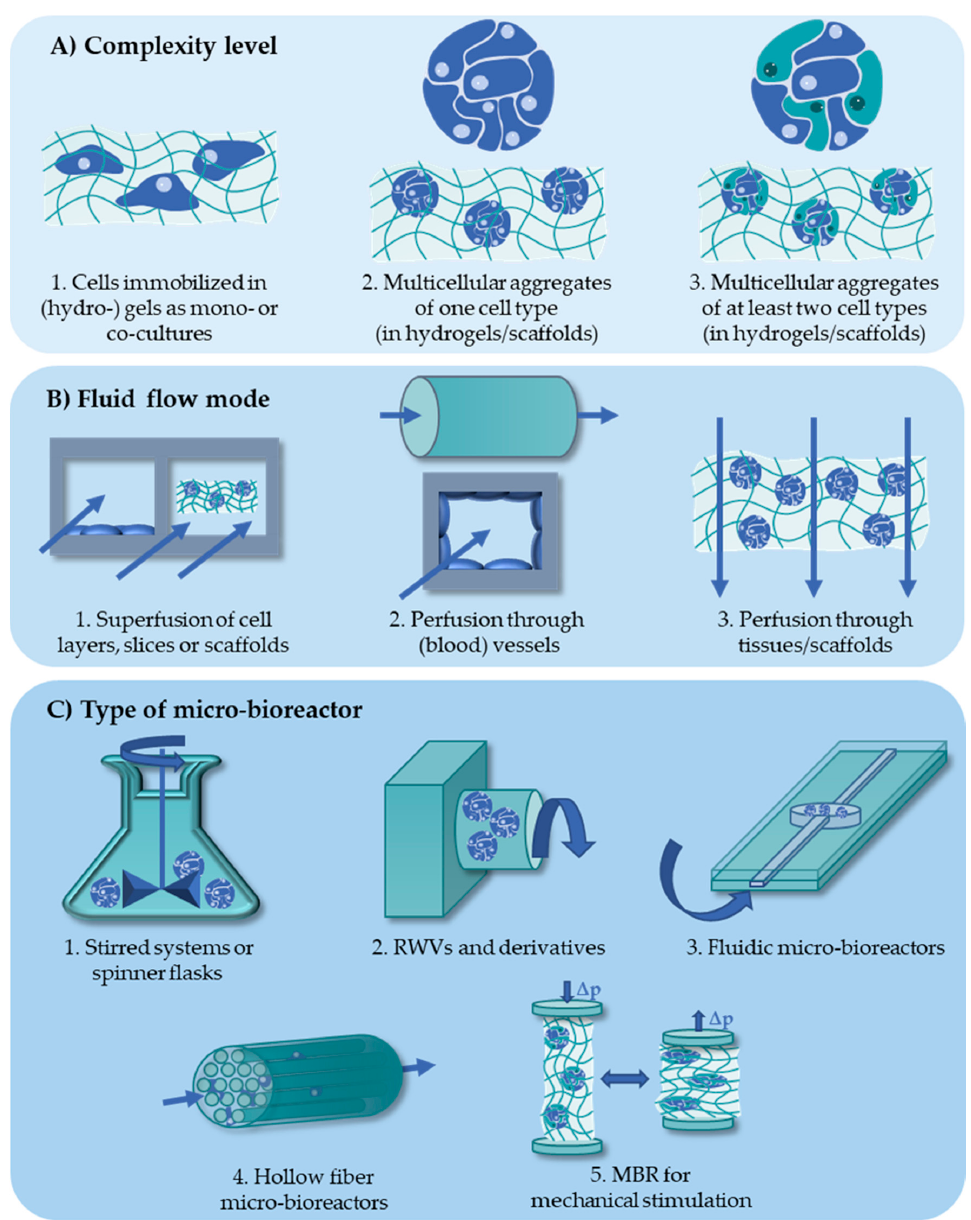
Figure 2. ( A ) Complexity levels defined by means of the applied 3D cell culture technique and with respect to the existing 3D microenvironment. ( B ) Differentiation between superfusion and perfusion of different 3D cell cultures. ( C ) Frequently used micro ‐ bioreactor (MBR) types: 1. based on spinner flasks or stirred tank systems, 2. rotating wall vessels (RWVs), 3. fluidic MBR, 4. hollow fiber bioreactors, and 5. MBR for mechanical stimulation. The sketches show examples of the structure of the respective MBRs. Details are discussed in review part II.